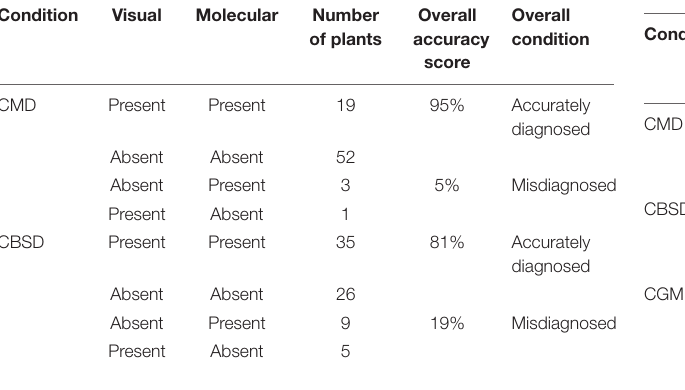
TABLE 1 | Comparison of visual and molecular diagnosis of CMD and CBSD.